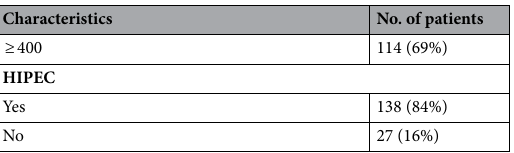
Table 1. Patients’ clinical and demographic data (n = 165). PSS prior surgical score, RBC red blood cell, Hb hemoglobin, ALB Albumin, PCI peritoneal cancer index, CCR completeness of cytoreduction, HIPEC hyperthermic intraperitoneal chemotherapy.